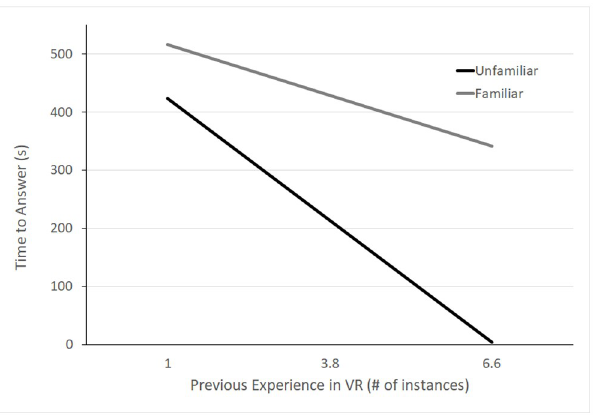
Fig 5. Response time. Predicted response times are plotted for both Familiar conditions with Experience in VR on the x-axis. Familiar pairs took longer to respond than unfamiliar pairs and this difference was exaggerated for pairs with more experience in